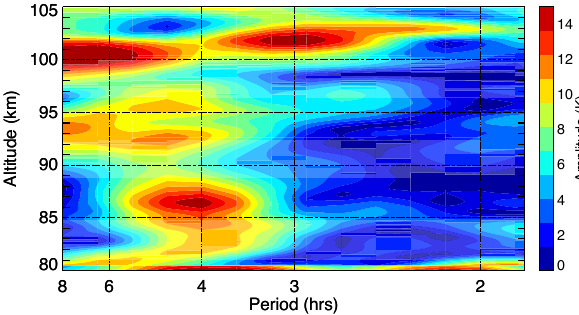
Figure 2. Periodogram as a function of altitude for the neutral temperature variation derived from the Lomb–Scargle method with oversampling factor 4.